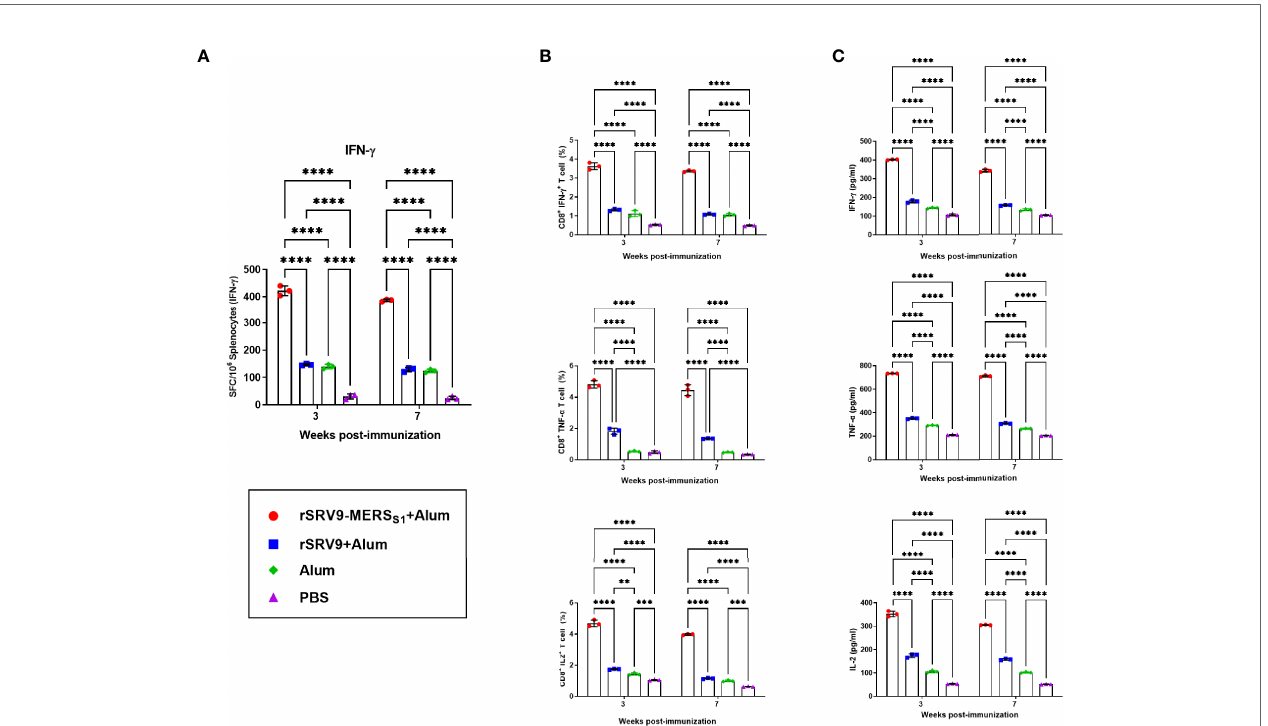
FIGURE 3 | CD8 + T-cell responses elicited by the inactivated rabies virus-vectored MERS-CoV vaccine. Splenocytes from each group of mice (n = 3) were harvested 1 and 4 weeks following the second immunization and evaluated for the vaccine-induced speci fi c cellular immune responses. (A) The MERS-CoV-speci fi c IFN- g activities in splenocytes were measured using commercial ELISpot kits. Spot-forming cells (SFCs) secreting IFN- g were enumerated in an automated ELISpot reader and shown as mean responses in each group at the indicated time points. (B) The frequencies of MERS-CoV-speci fi c IFN- g -, TNF- a -, and IL-2-secreting CD8 + T cells in splenocytes were evaluated using intracellular cytokine staining (ICS) assays. (C) Levels of IFN- g , TNF- a , and IL-2 secreted by splenocytes were measured using commercial ELISA kits. Data are shown as mean ± SD. Data were obtained using the GraphPad Prism version 9.0 (GraphPad software). Signi fi cance was calculated using a two-way ANOVA with multiple comparisons tests (not indicated in graph; **p < 0.01, ***p < 0.001, ****p <